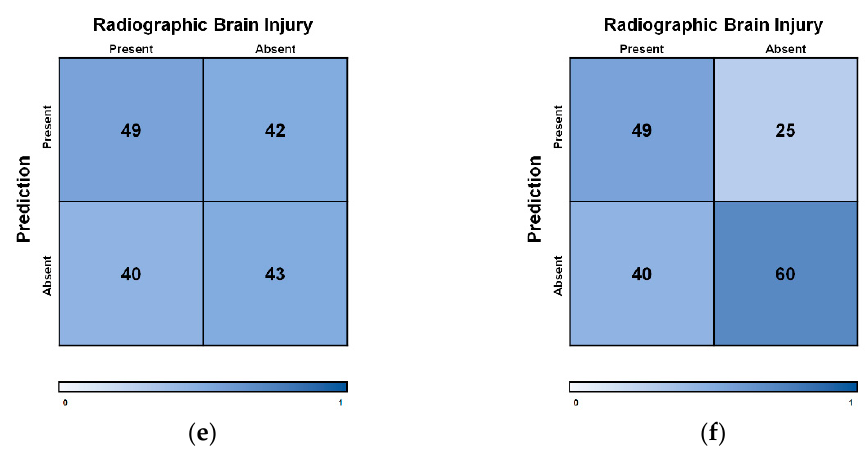
Figure A2. (a) Demonstrates model’s confusion matrix when after removal of acid-base factors during feature masking. (b) Demonstrates model’s confusion matrix when after removal of coagulation factors during feature masking. (c) Demonstrates model’s confusion matrix when after removal of ECMO machine factors during feature masking. (d) Demonstrates model’s confusion matrix when after removal of markers of perfusion during feature masking. (e) Demonstrates model’s confusion matrix when after removal of vital signs during feature masking. (f) Demonstrates model’s confusion matrix when after removal of vasoactives during feature masking.